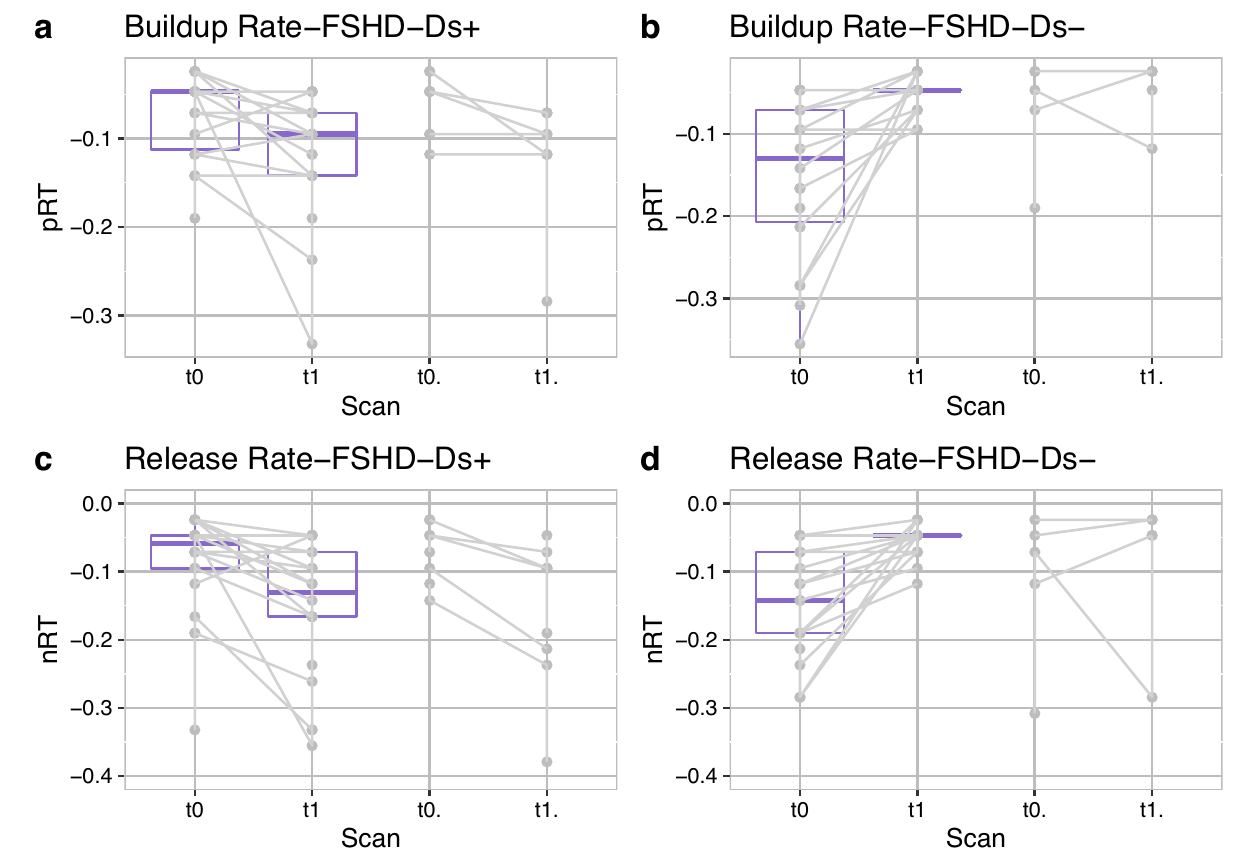
Figure 5. Build-up & release rates comparison between patients and healthy controls (HCs). ( a ) Build-up rate for the first two scans for the FSHD-Δs+ patient group and the HC group (22 for FSHD, 9 for HCs), ( b ) build-up rate for the FSHD-Δs− patient group and the HC group (23 for FSHD, 4 for HCs), ( c ) release rate for the first two scans for the FSHD-Δs+ patient group and the HC group (22 for FSHD, 9 for HCs), ( d ) release rate for the FSHD-Δs− patient group and the HC group (23 for FSHD, 4 for HCs). FSHD-Δs+ /FSHD-Δs− : groups of the strain data of FSHD patients based on the changes between t0 and